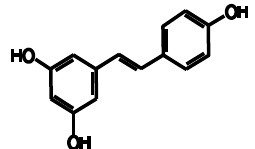
Figure 1. trans -Resveratrol structure.